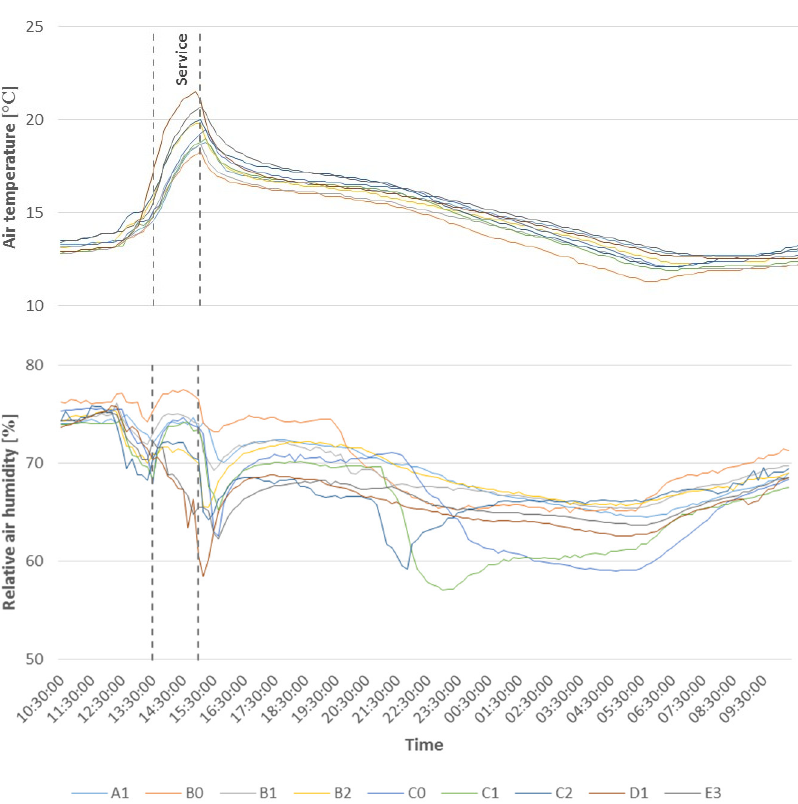
Figure 7. The course of air temperature and relative humidity inside the building in summer (20 May 2018).